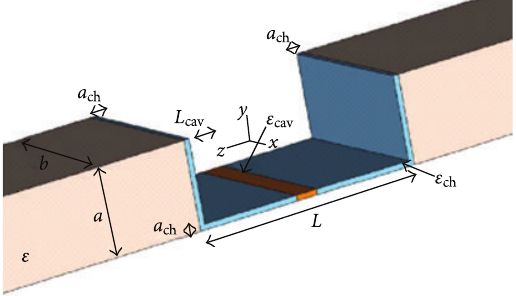
Figure 19: Geometry model of the permittivity sensor